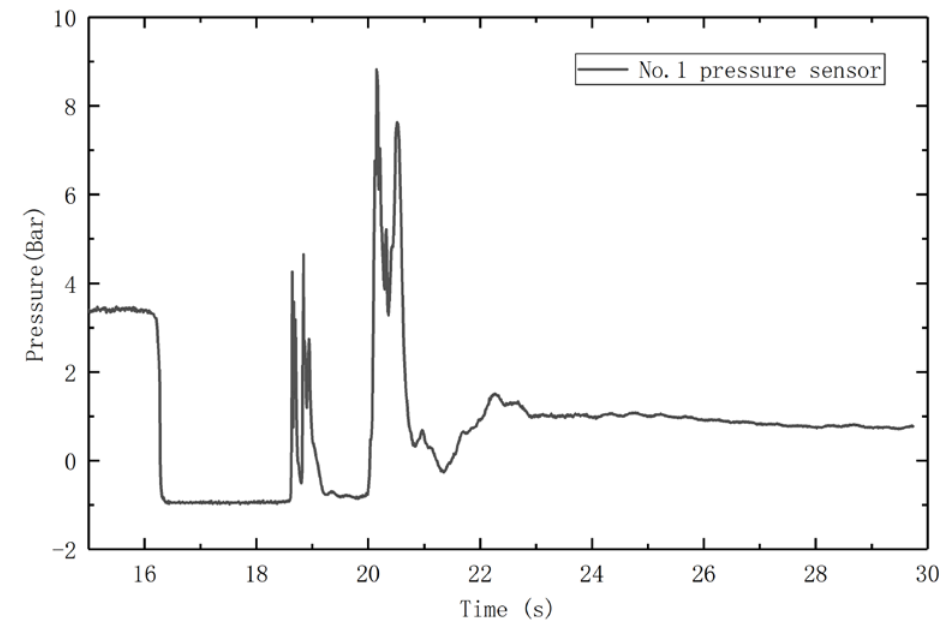
Figure 8. Instantaneous pressure of No. 1 pressure sensor.